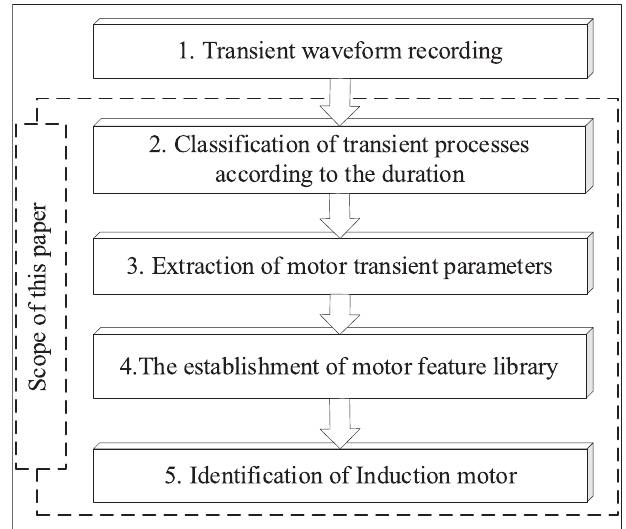
FIGURE 1 | Load identi fi cation method of induction